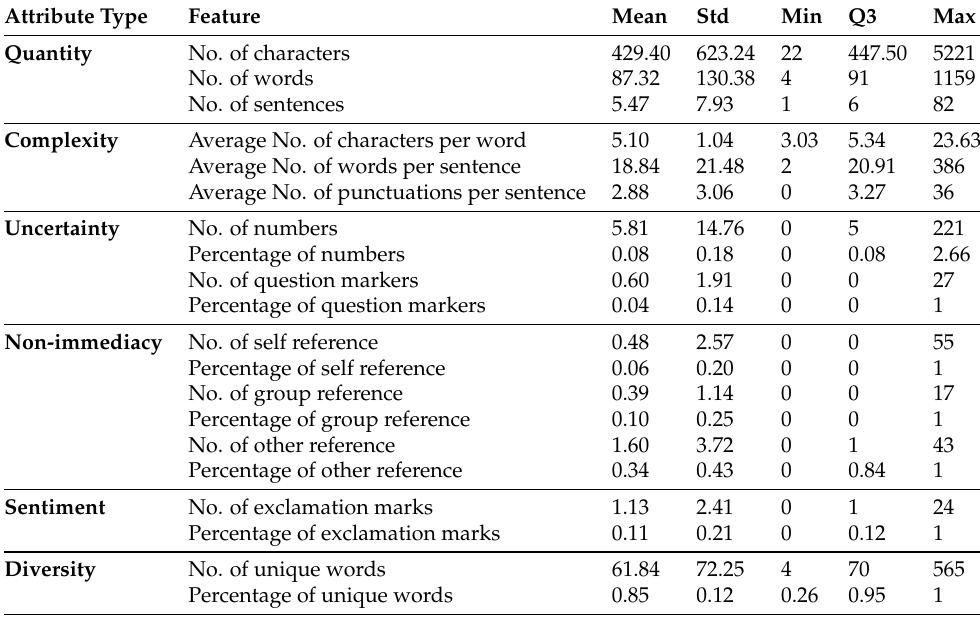
Table 1. Textual attributes and features of fake news that circulated in Brazil from January 2020 to February